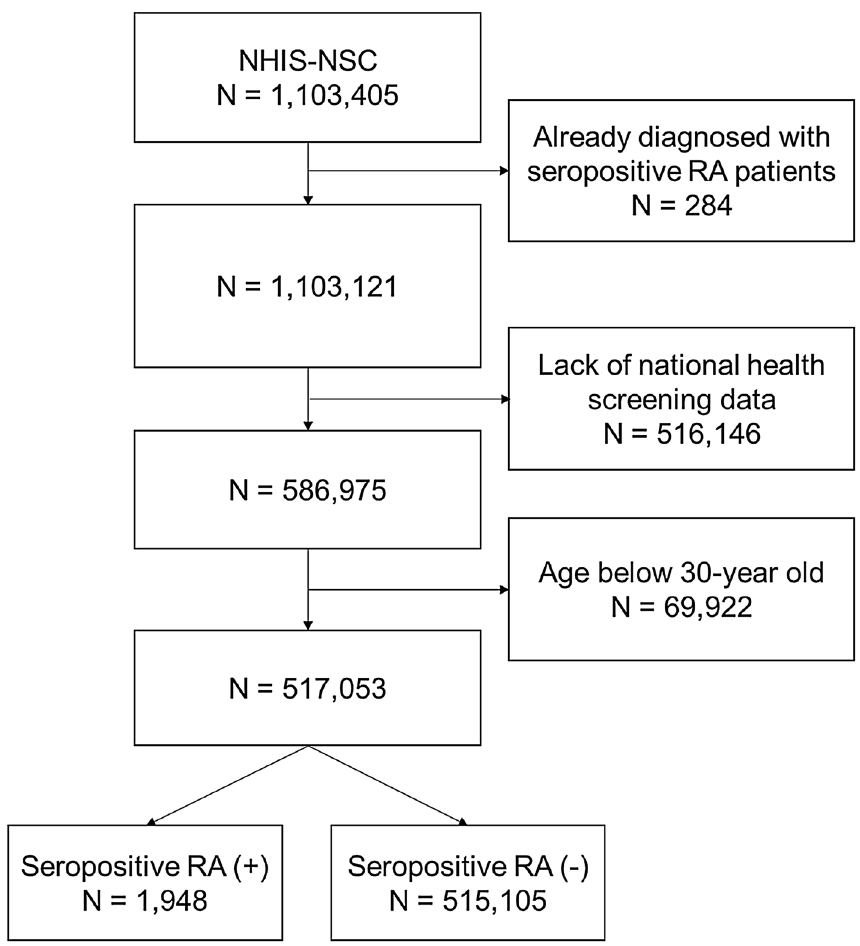
Figure 1. Flow chart for step-wise exclusion of participants from National Health Insurance Service-national sample cohort